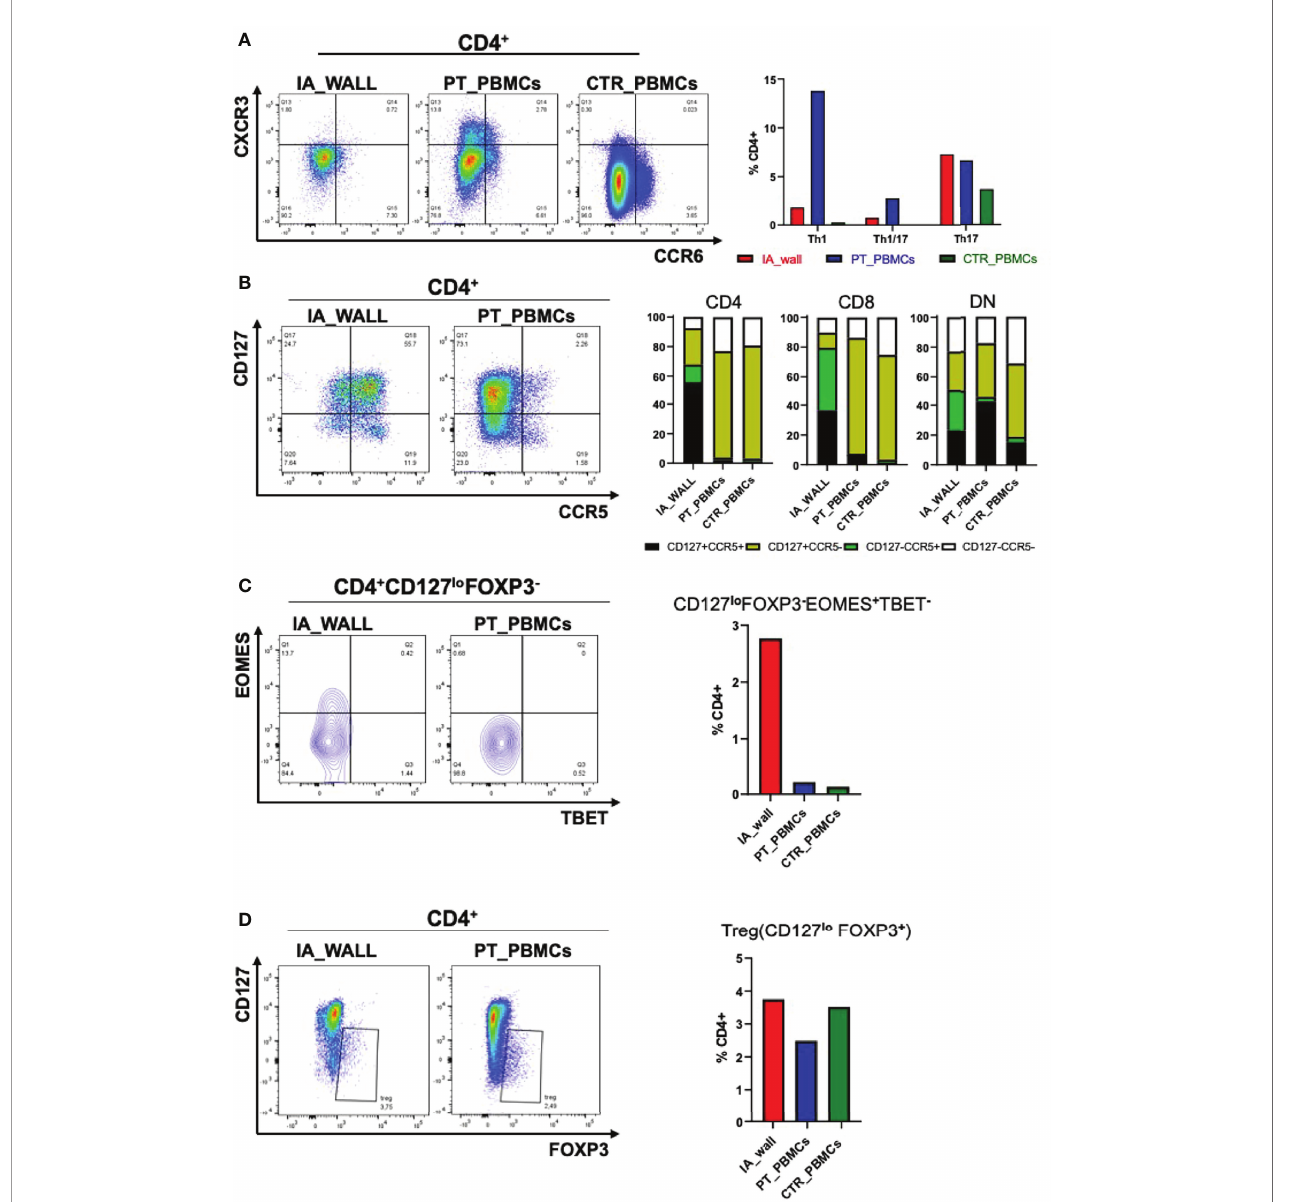
FIGURE 4 | Differential distribution of helper and regulatory T-cell subsets in the IA wall and in peripheral blood. (A) Th1 (CXCR3+CCR6-), Th1/17 (CXCR3+ CCR6+) and Th17 (CXCR3- CCR6+) subsets were analysed on gated CD4+ T-cells. Dot plots show CXCR3 versus CCR6 expression in the IA_WALL, in the peripheral blood of the patient (PT_PBMCs, middle) and of the pediatric control (CTR_PBMCs, right). (B) CD127 and CCR5 surface expression. Dot plots show CCR5 versus CD127 expression in the IA wall and in the blood of the patient. Bar Histograms report the frequencies of CD127+/-CCR5+/- cells (colored as indicated) among CD4+, CD8+ and in DN T-cells in the 3 samples as indicated. (C) EOMES + Tr1-like cells were gated fi rst as CD4+CD127 lo FOXP3- and then as Eomes+T-bet-/lo. Their frequencies among CD4 +T-cells was reported in the IA wall (red), in peripheral blood of the patient (blue) and of the pediatric control (green). (D) FOXP3+ regulatory T-cells (Treg) cells were gated as CD127 lo FOXP3+ and their frequencies among CD4+T-cells in the three samples are reported in the right bar histograms as in